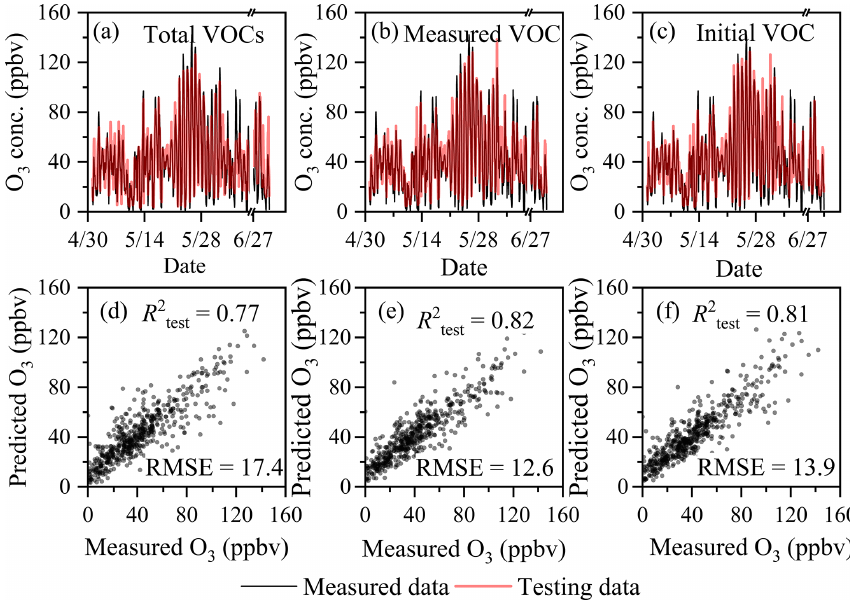
Figure 2. Comparison of the predicted and measured O 3 concentrations in Beijing in the summer of 2015 ( a, d : TVOC concentrations; b, e : measured concentrations of VOC species; c, f : initial concentrations of VOC